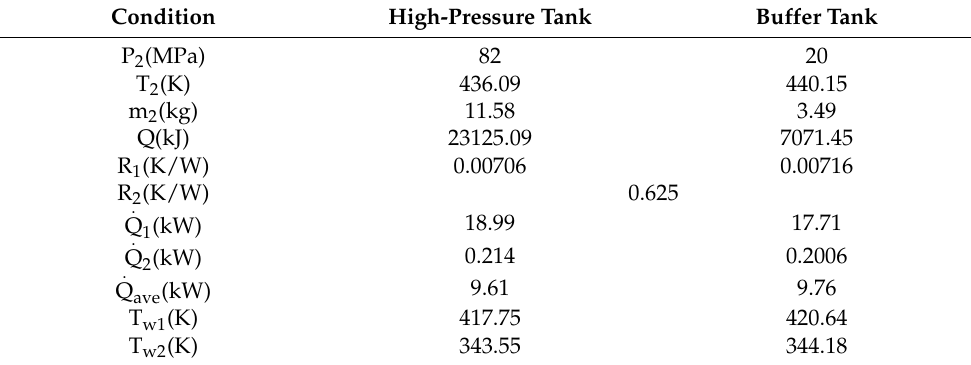
Table 6. Results of the first cycle of the compressed hydrogen storage